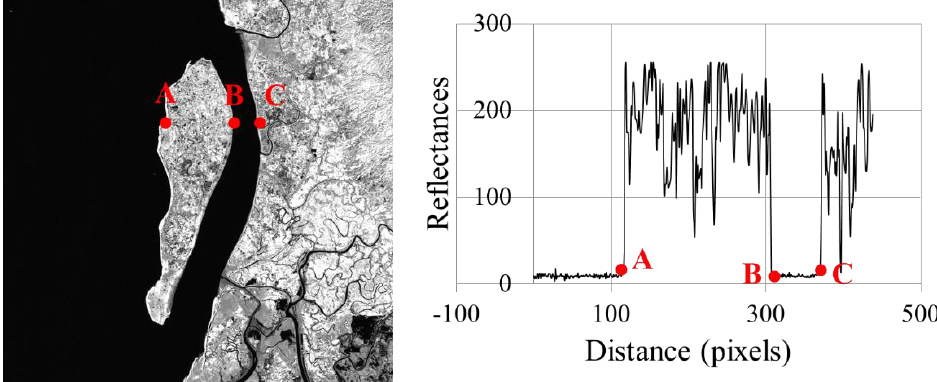
Figure 5. The reflectance intensity variation of LANDSAT Band 5 image. Points A, B, and C represent the land-water interfacial points.